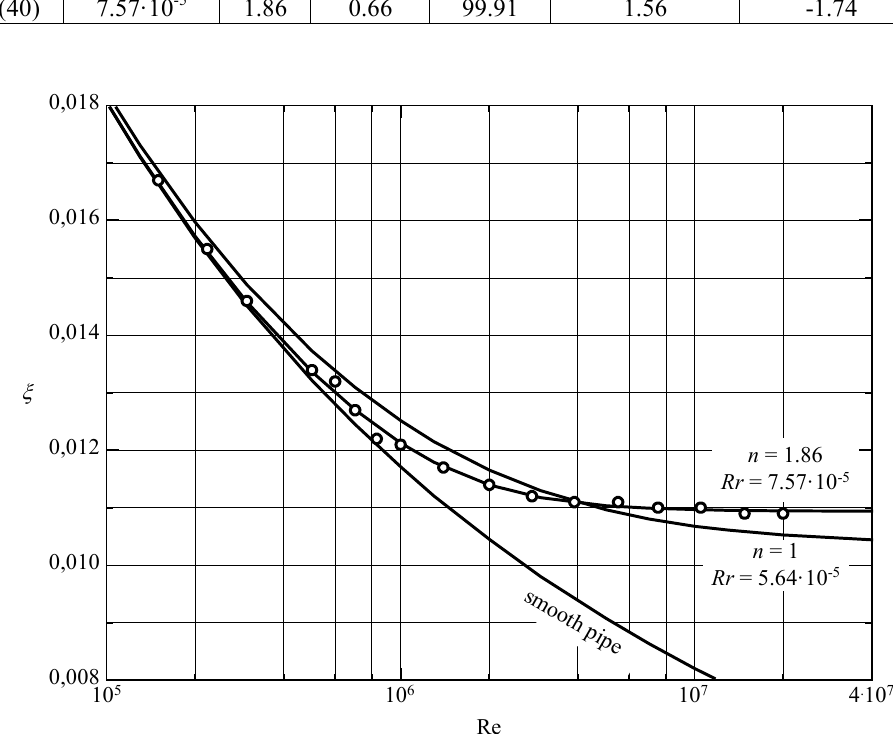
Table 6 Statistical parameters of (38)